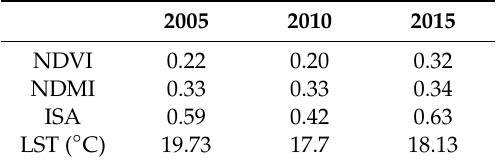
Table 1. The mean value of NDVI, NDMI, ISA, and LST in the three periods.